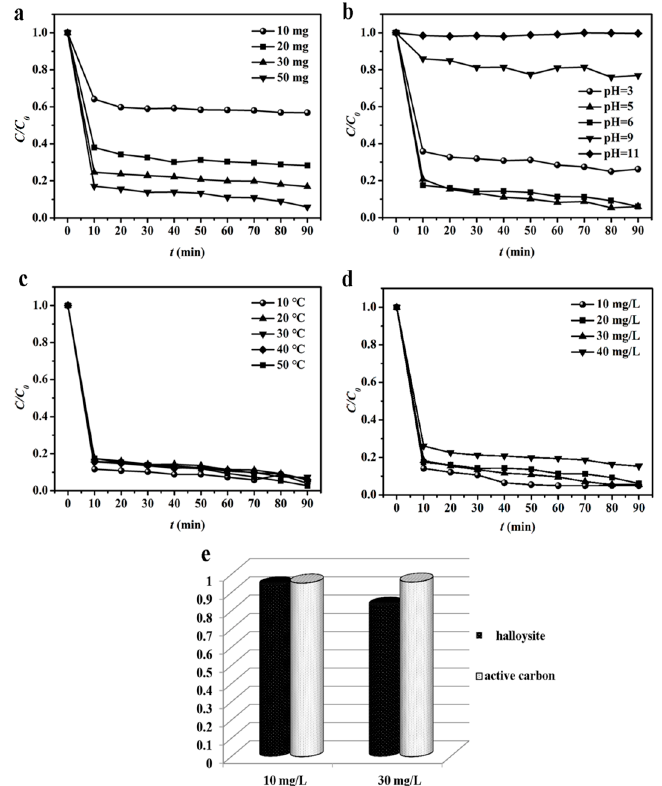
Figure 1. Effects of adsorbent dosage ( a ), pH value ( b ), temperature ( c ), and initial ciprofloxacin (CIP) concentration ( d ) on the adsorption efficiency of halloysite nanotubes (HNTs) toward CIP. The comparison of adsorption efficiencies between HNTs and active carbon at various CIP concentration ( e ).